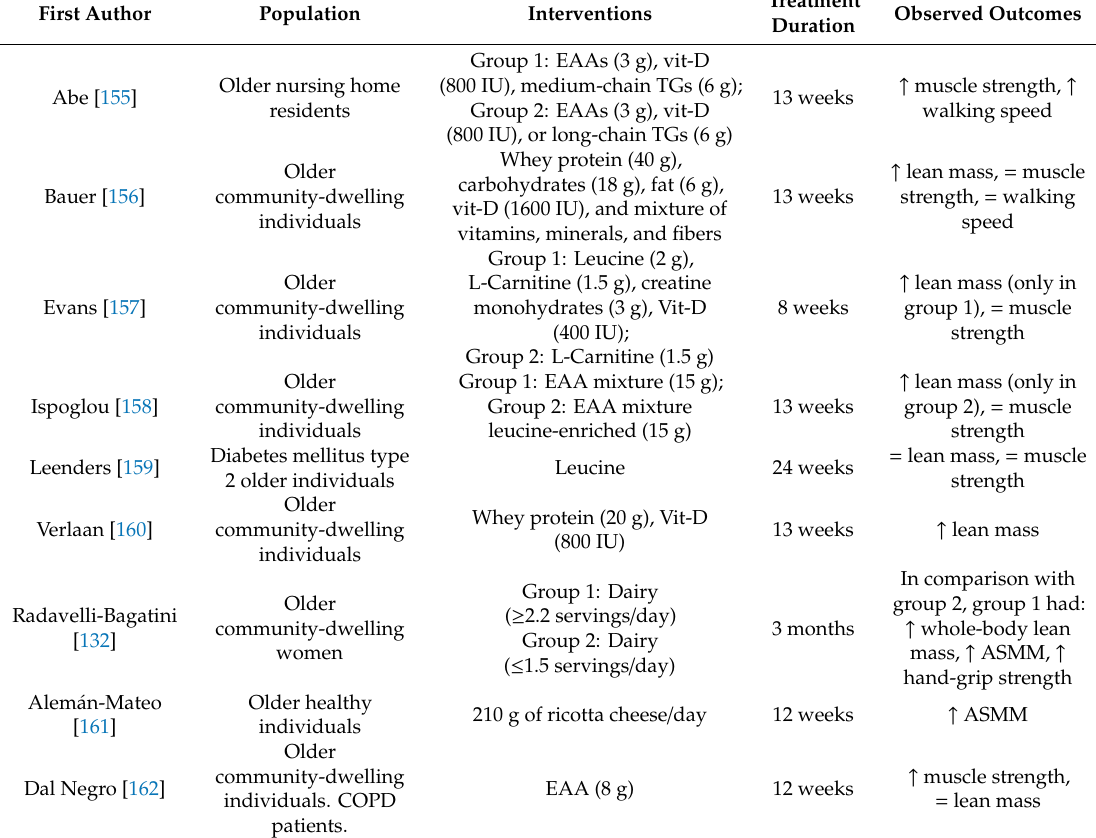
Table 3. Impact of nutrition and supplementation in